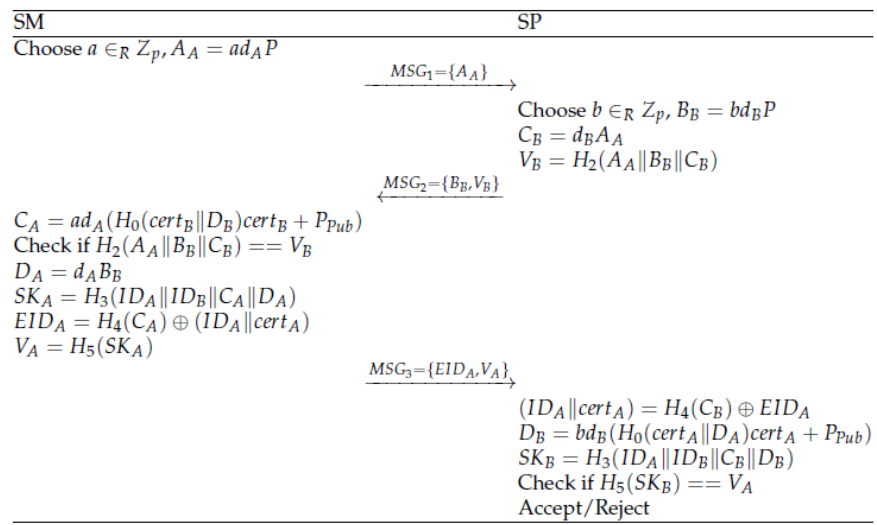
Figure 4. Steps and computations in the key agreement phase of Abbasinezhad et al.’s scheme